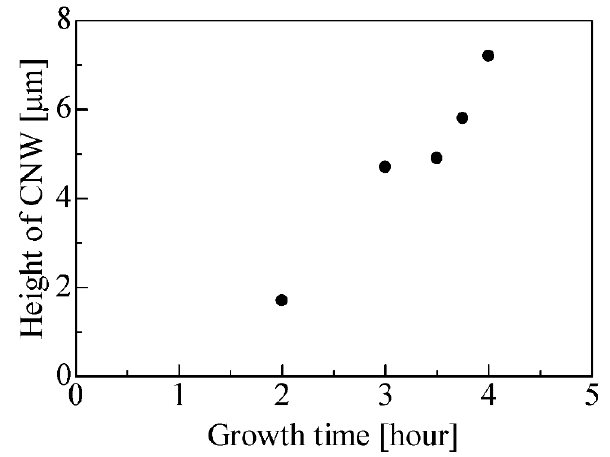
Figure 3. Height of CNW as a function of growth time.